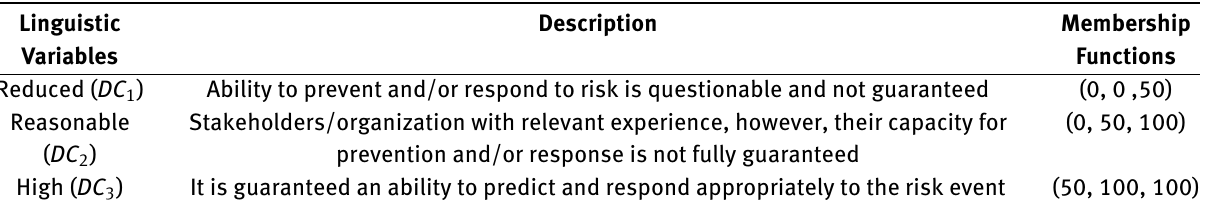
Table 3: Linguistic Variables for the Detection/Control ( DC ) and Membership Functions. Linguistic Variables